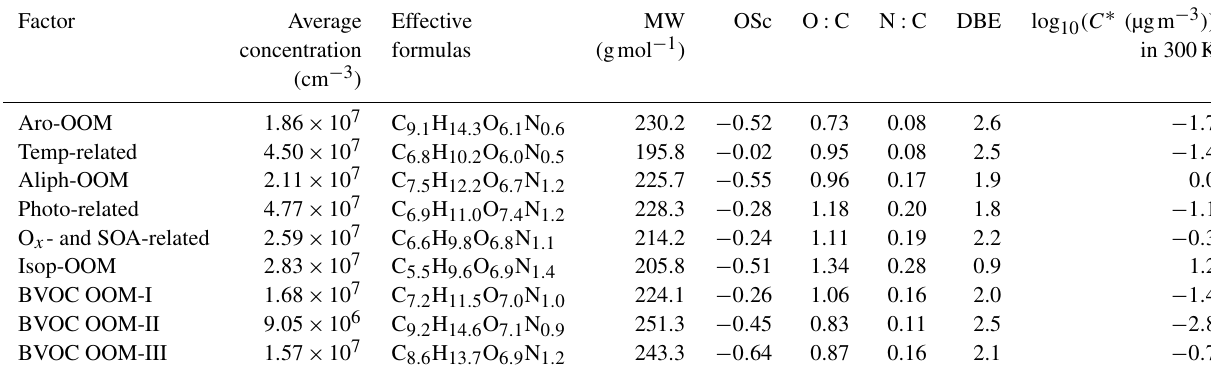
Table 1. Summary of molecular characteristics of nine discussed non-nitrated-phenol factors. The calculation of the relevant parameters is given in Sect. S3 in the Supplement. Major peaks of each factor are summarized in Sect. S4 in the Supplement. Factor